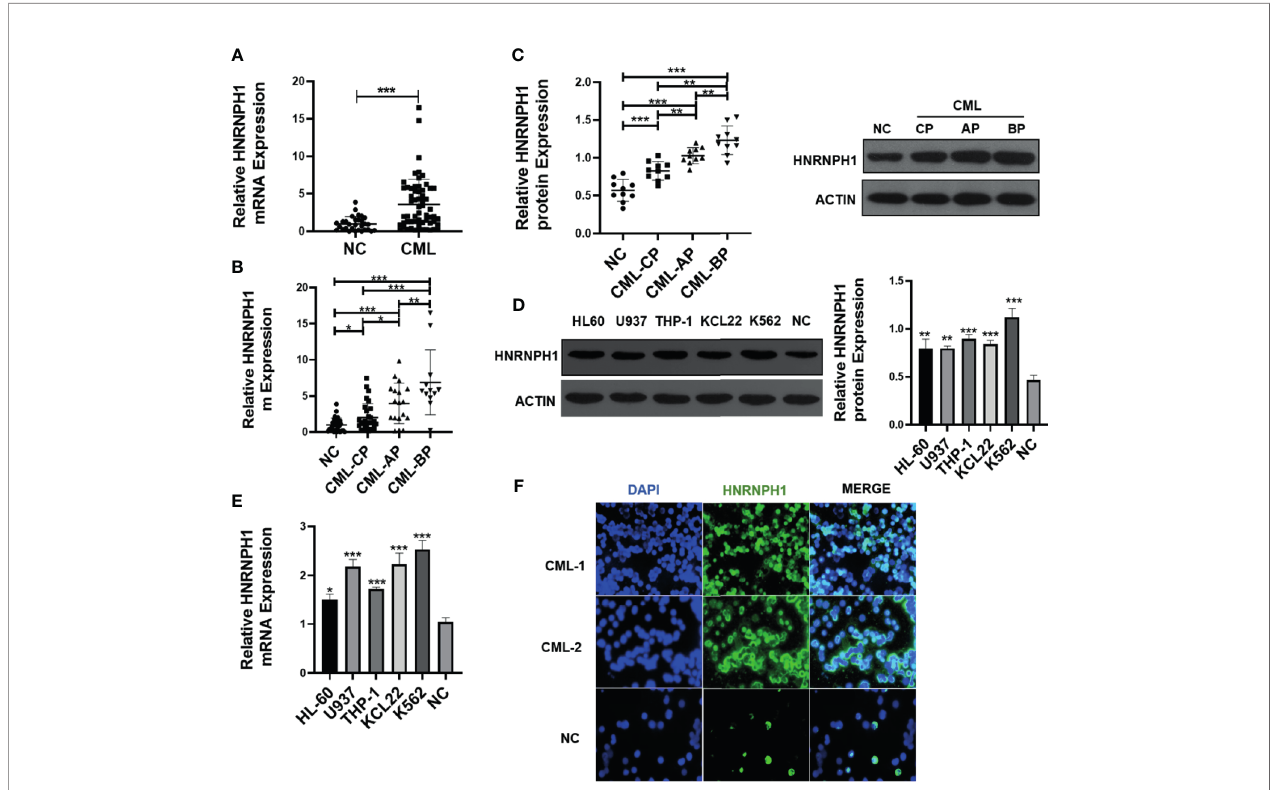
FIGURE 1 | HNRNPH1 is upregulated in CML patients and cell lines. (A) qRT-PCR was used to detect HNRNPH1 mRNA level in BM-MNCs of CML patients and BM-MNCs of healthy donors. Normalized to GAPDH. ***P < 0.001 vs . NC. (B) qRT-PCR was used to detect HNRNPH1 mRNA level in different phases of CML (CML-CP, CML-AP, and CML-BP) patients ’ BM-MNCs compared with normal controls. *P < 0.05, **P < 0.01, ***P < 0.001. (C) Western blot was used to detect HNRNPH1 protein levels in different phases of CML (CML-CP, CML-AP, and CML-BP) patients ’ BM-MNCs compared with normal controls. Left panel, scatter plots of protein densitometric analysis. **P < 0.01, ***P < 0.001. (D) Western blot was used to detect HNRNPH1 protein levels in leukemia cell lines (HL-60, U937, THP-1, K562, and KCL22) and BM-MNCs of normal controls. Right panel, densitometric analysis. **P < 0.01, ***P < 0.001 vs . NC. (E) qRT-PCR was used to detect HNRNPH1 mRNA levels in leukemia cell lines (HL-60, U937, THP-1, K562, and KCL22) and BM-MNCs of normal controls. *P < 0.05, ***P < 0.001 vs. NC. (F) Immuno fl uorescence analyzed the HNRNPH1 protein level and localization of HNRNPH1 in PBMCs of CML-CP patients and BM-MNCs of normal